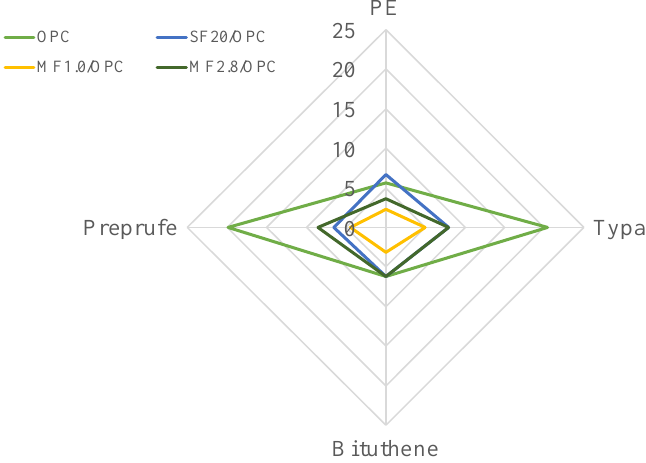
Figure 12. Comparison for residual stress between fiber addition and OPC.